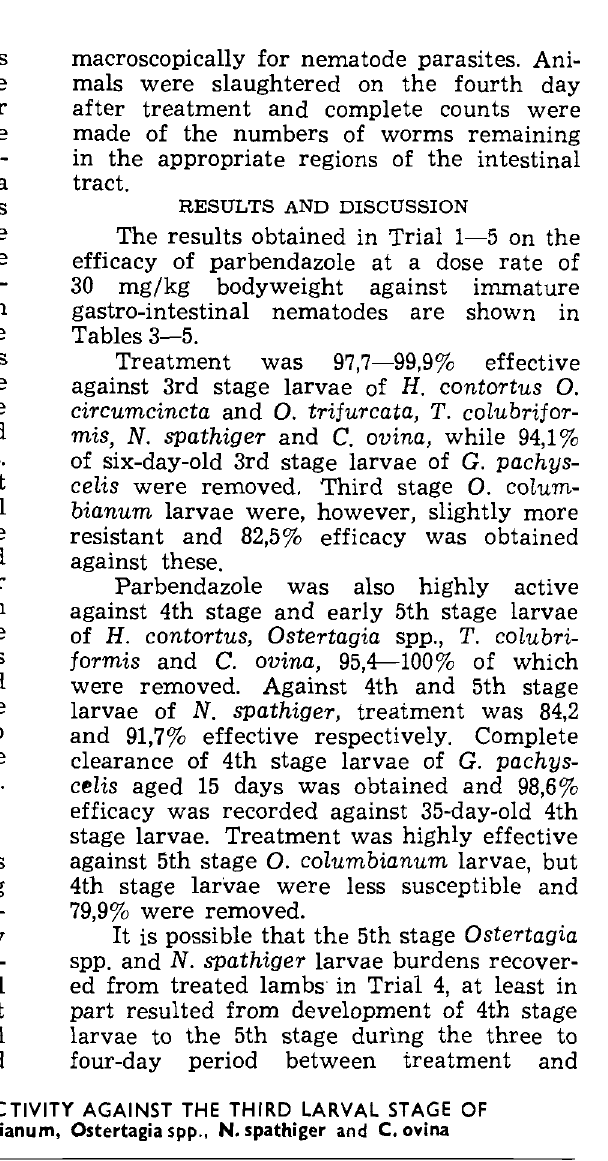
Efficacy Parbendazole